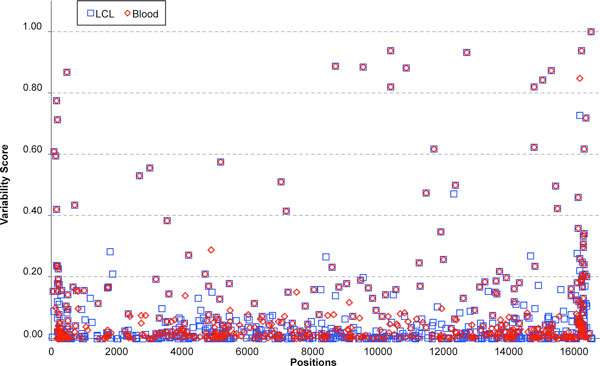
Variability profile of blood and LCL genomes. Variability values estimated on nearly 10,000 mitochondrial nucleotide multi-aligned sequences, available in HmtDB web site [33] are reported versus the variant positions observed in both blood and LCL samples. The trend is similar for both datasets: almost all of the variant positions display a very low variability (<0.20). Positions showing high variability, i.e. those which were common in the genomes within HmtDB, were few and represented the 25% of total shared variants between the two datasets, while the majority of non-shared variants (about 98%) displayed low variability.